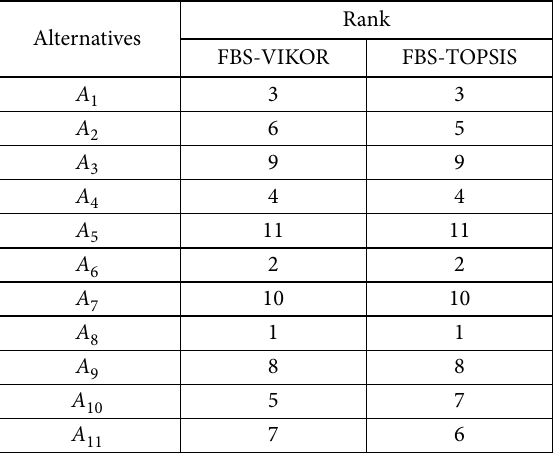
Table 6. Final ranking and comparison